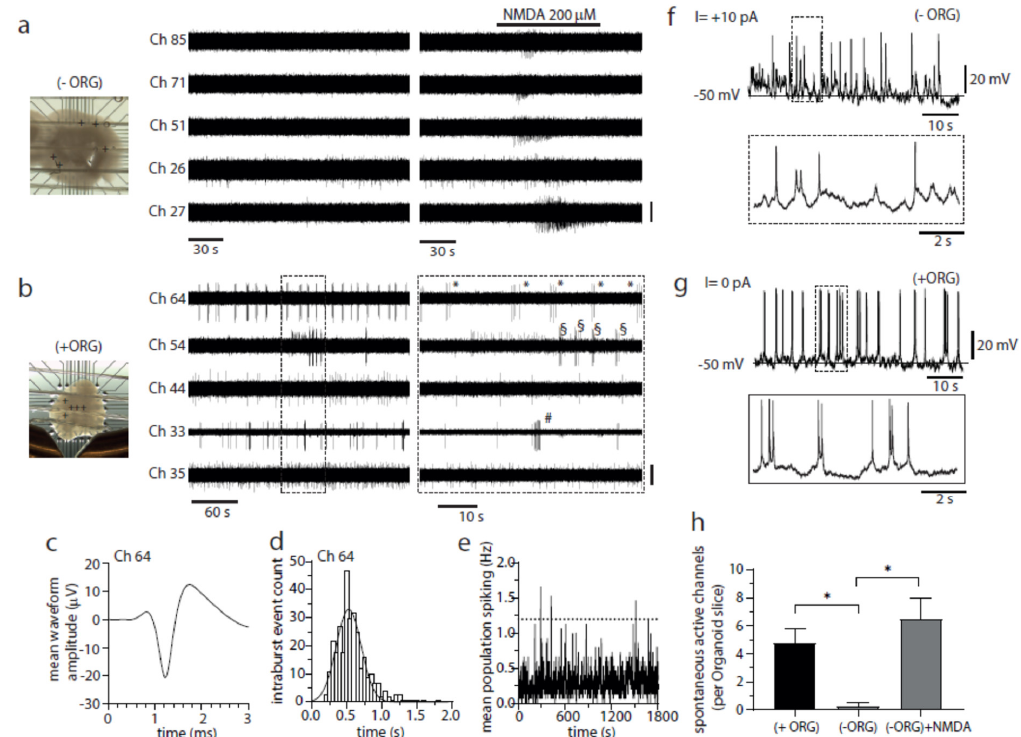
Figure 4. Incorporated IBA1+ population promotes neuronal bursting and network activity in cerebral organoids. ( a ) Image of an (−)ORG slice recorded with a 3D 8 × 8 MEA (left) and raw voltage recordings of spiking activity from five representative electrodes (depicted as + symbols on image) before and after NMDA perfusion (middle and right panels). Only channel 26 exhibited activity in baseline conditions (one active electrode detected from 4 organoid slices), while NMDA perfusion effectively and quickly elicited a brief burst of activity on all five channels (bar, 20 µV). ( b ) As described above in a but for a (+)ORG slice. The regular bursting activity of 3–7 spikes was detected in three electrodes (33, 54, 64) (twenty-four active electrodes detected from 5 -organoid slices). Symbols (*, # and §) mark individual bursts in each different channel (bar, 20 µV, except for Ch 33, 40 µV). ( c ) Mean spike waveform after spike sorting (255 spikes) using principal component analysis from raw signal depicted in b from channel 64. A single tight cluster with a well-defined AP waveform was detected consistent with the recording being from a single neuron (single unit activity, SUA). ( d ) Intra-burst spike interval histogram (50 ms bins) for SUA from channel 64 presented in (b,c). Ten of total 24 active electrode tracks detected from 5 (+)ORG slice-organoids exhibited signs of bursting. The single Gaussian function fitted to the data is centred at 524 ± 178 ms (mean ± SD) while the mean inter-burst interval for this neuron was 10.7 ± 4.2 s (mean ± SD). ( e ) Mean population spike activity from all the active electrodes the (+)ORG slice presented in b (in 1 s bins). Although individual electrodes exhibited bursting activity, this activity was largely asynchronous between electrodes, as seen by the typical flattened population spiking response over the time course of 10 min (dotted line represents network burst threshold set at 6 times the SD of the baseline). ( f ) Electrophysiological traces from whole-cell recording from a (−)ORG neuron exhibiting a current-induced (+10 pA) low amplitude, short term bursting behaviour. ( g ) Electrophysiological traces from whole-cell recording from a (+)ORG neuron exhibiting high amplitude, robust, regular bursting behaviour from its resting membrane potential. ( h ) Bar chart comparison of active electrode tracks recorded per organoid slice. (+)ORG slices exhibited a statistically significant larger number of detected active electrode tracks compared to (−)ORG slices. This lack of spontaneous activity could be reversed by perfusion of NMDA that caused the emergence of transient activity on previously silent electrodes recorded from (−)ORG slices (1 vs. 24 active electrodes, n = 4 (−)ORGs and n = 5 (+)ORGs, respectively, from two independent batches). All recording were made from organoids of the iPCS line MBE2968.